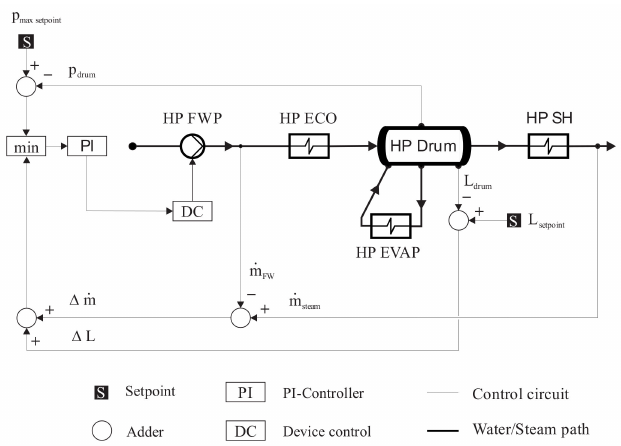
Figure 4. The HP drum level